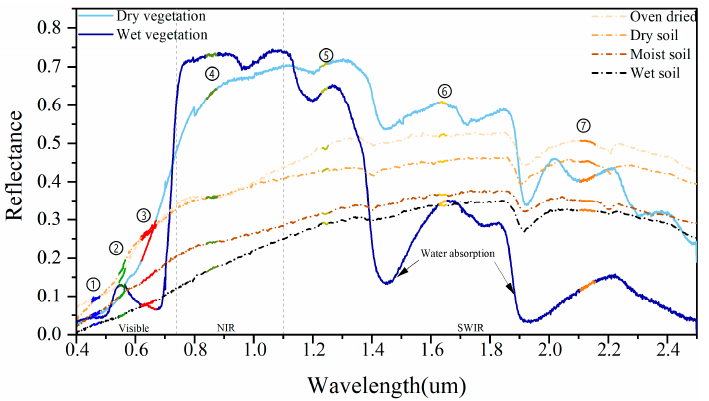
Figure 10. Spectrum features of vegetation and soil with different water content where ① – ⑦ rep- resent the band positions of Blue, Green, Red, NIR, SWIR1, SWIR2, and SWIR3 in